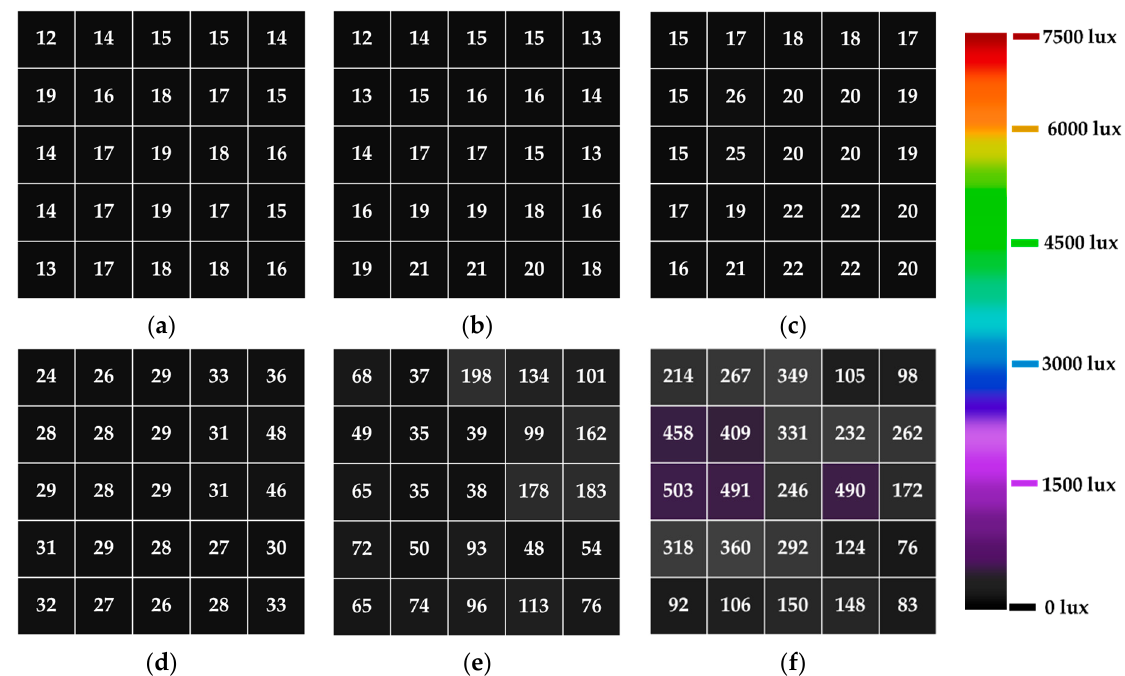
Figure 13. Illuminance distribution on the floor from the zinc alloy light tube at the incident angles of ( a ) 0°, ( b ) 15°, ( c ) 30°, ( d ) 45°, ( e ) 60°, and ( f ) 75°.